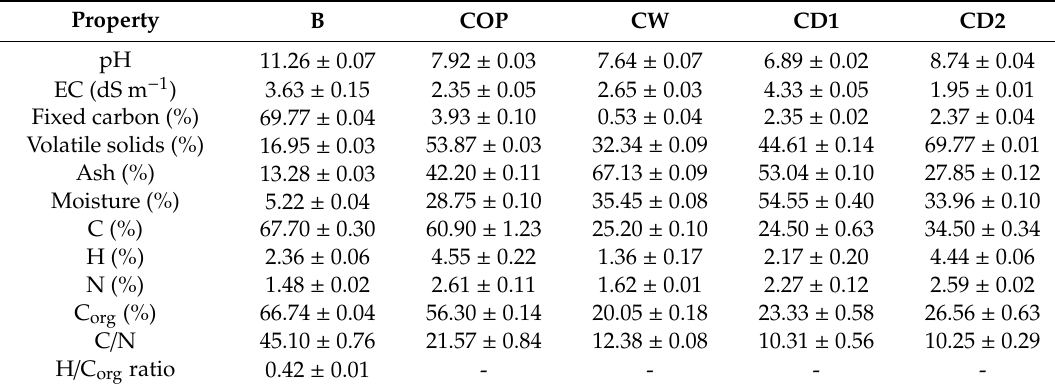
Table 2. Main chemical properties of biochar, vermicompost, and composts applied to the soil.